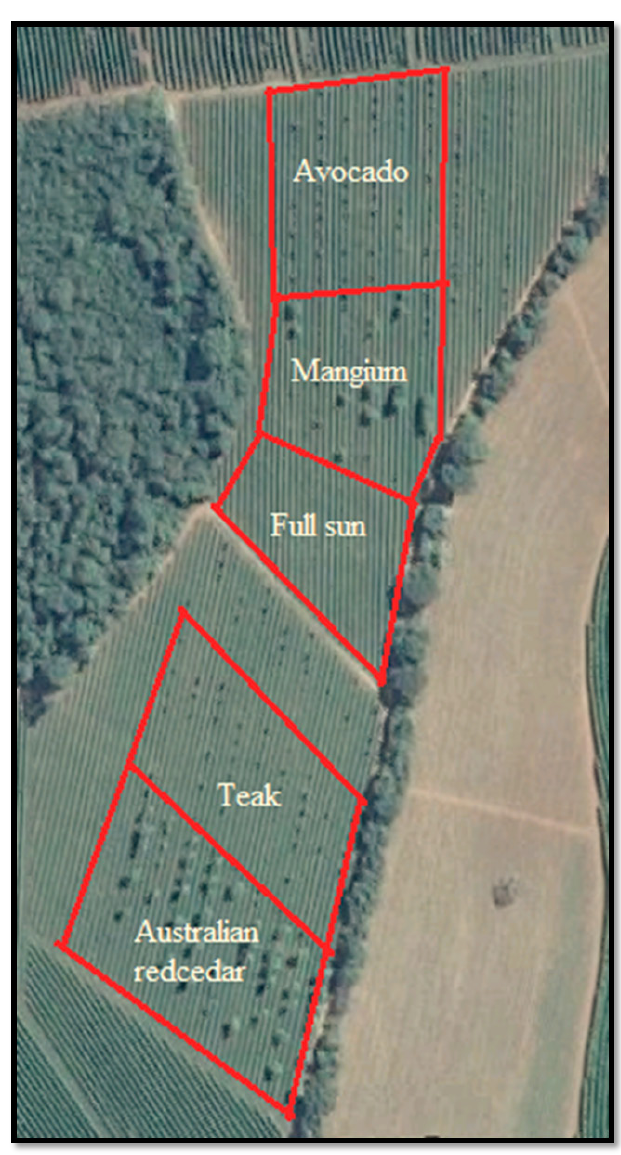
Fig 1 . Aerial image of the sample area with separation of plots. Santo Antônio do Amparo,